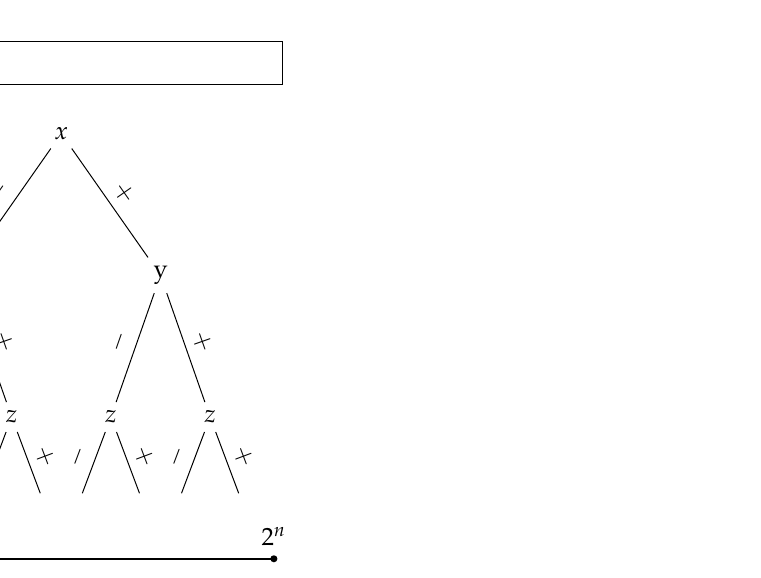
Figure 4. Decision tree presentation of MAX SAT with 3 variables. Numbers on the bottom imply the possible parameters for the univariate function.